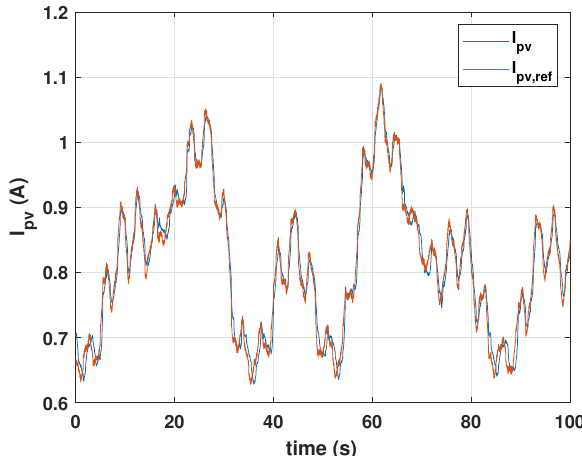
Figure 16. Output current of the PV